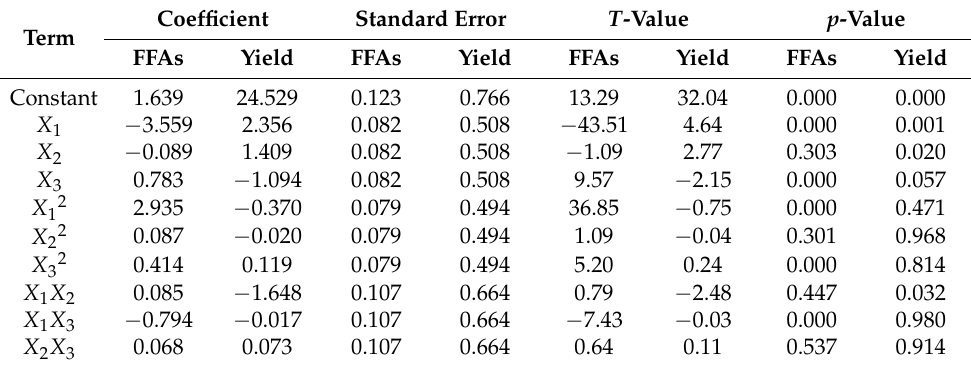
Table 3. Regression coefficient and their significance of the quadratic